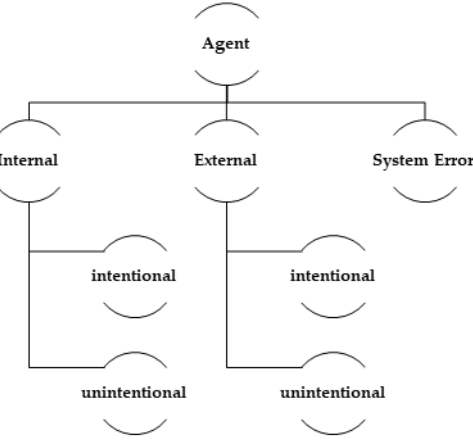
Figure 3. Types of attacking agents for security threats in security requirements framework.